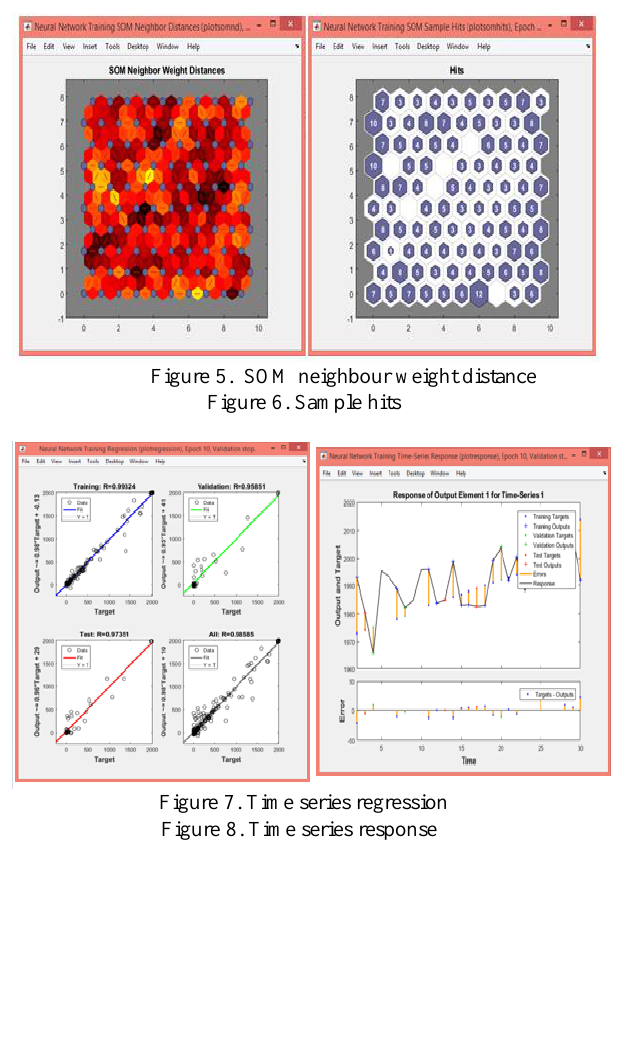
Figure 4. Image recognition mechanism